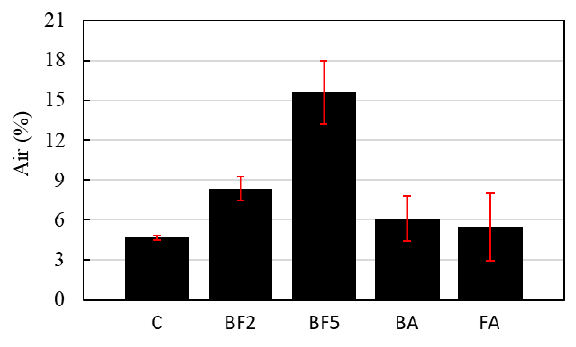
Figure 4. Air content test results.